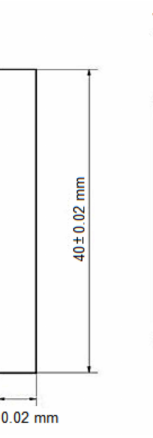
Figure 4. The shape and dimensions of a specimen for slurry erosion